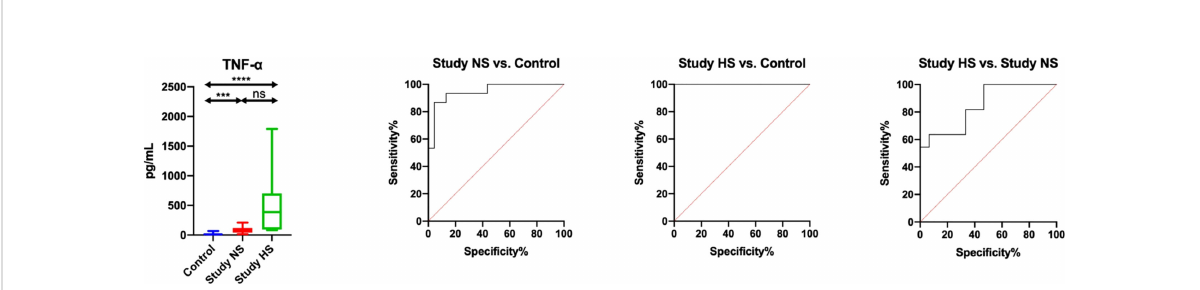
FIGURE 3 Diagnostic signi fi cance of salivary TNF- a for evaluating salivary gland in fl ammation in patients heart failure and hyposalivation (HS) compared to patients with heart failure (n = 13) and normal saliva secretion (n = 17) (NS) and to the control (n = 30). ***p< 0.001, ****p< 0.0001, ns, non signi fi